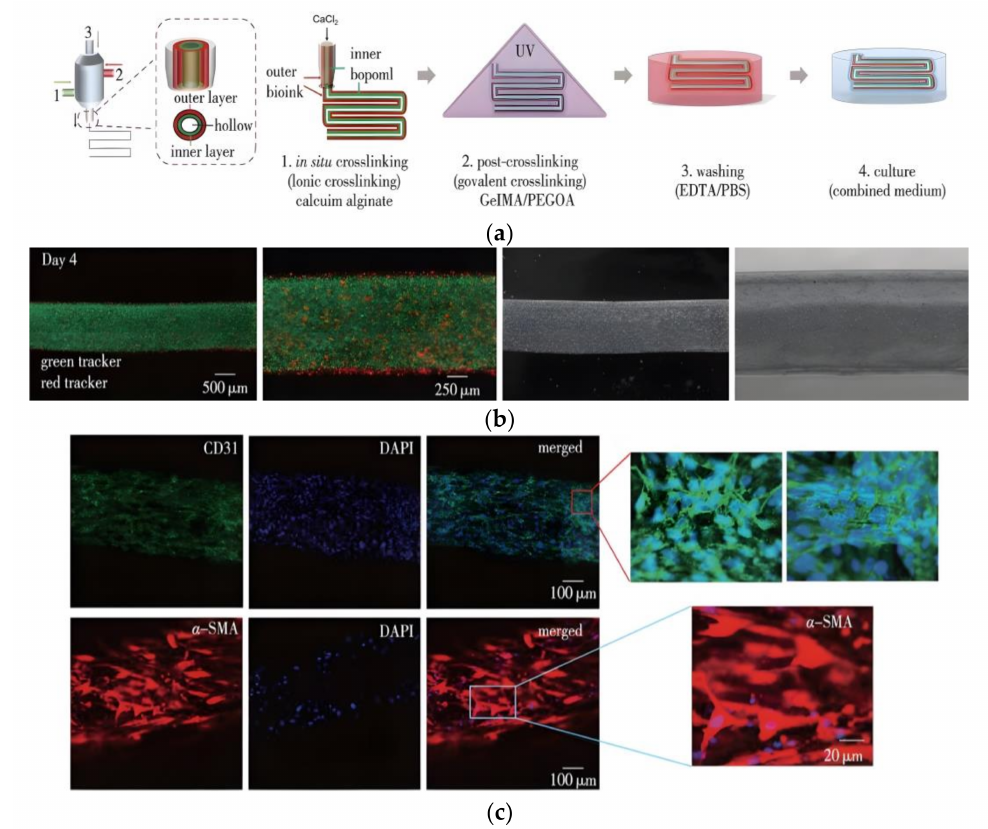
Figure 8. Digitally modulated microfluidic bioprinting of complex tubular tissues. ( a ) Schematic illustration of the MCCES and the process of bioprinting of a multilayered hollow tube. ( b ) Fluo- rescence images of the bioprinted inner human urothelial cells labeled with green cell tracker and the outer human bladder smooth muscle cells labeled with red cell tracker on day 14. ( c ) Confo- cal microscopy images of the immunostained vascular tubes after 14 d showing the expression of vascular cell-specific biomarkers, CD31 (green) and VE-cadherin (green) by HUVECs, and α -SMA (red) by